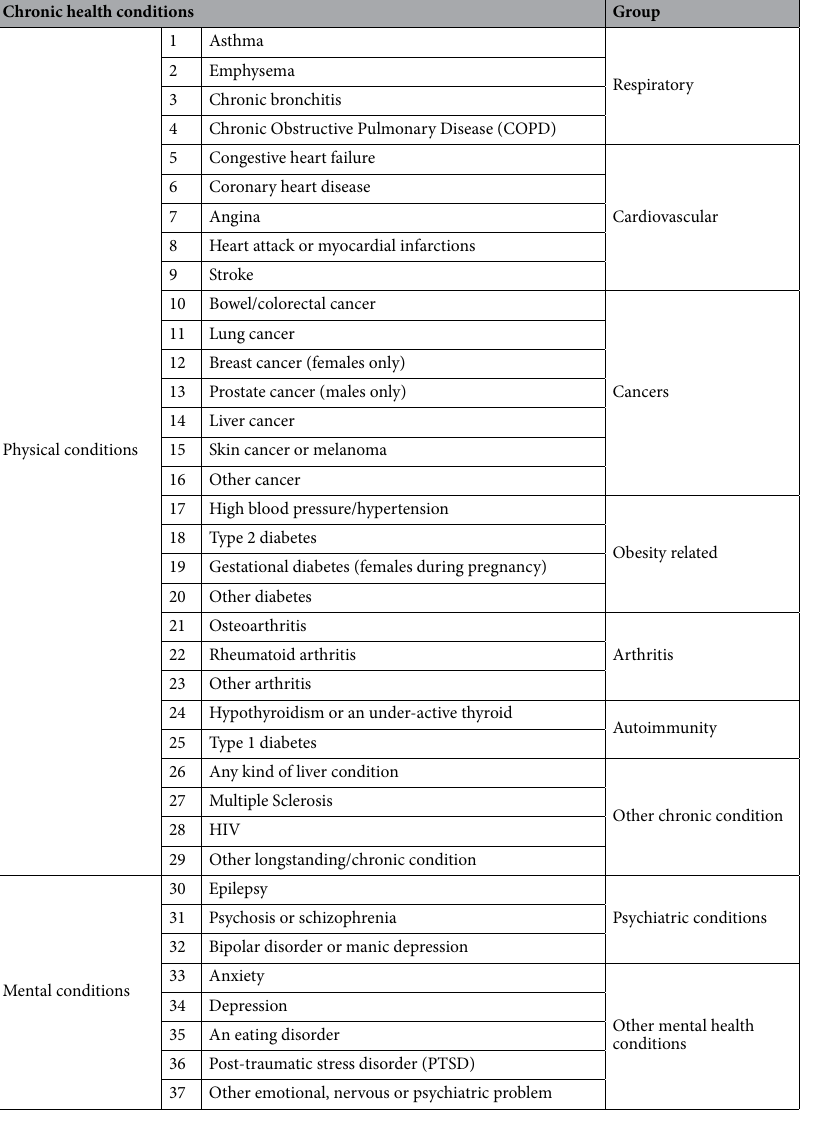
Table 1. List of chronic health conditions surveyed in Understanding